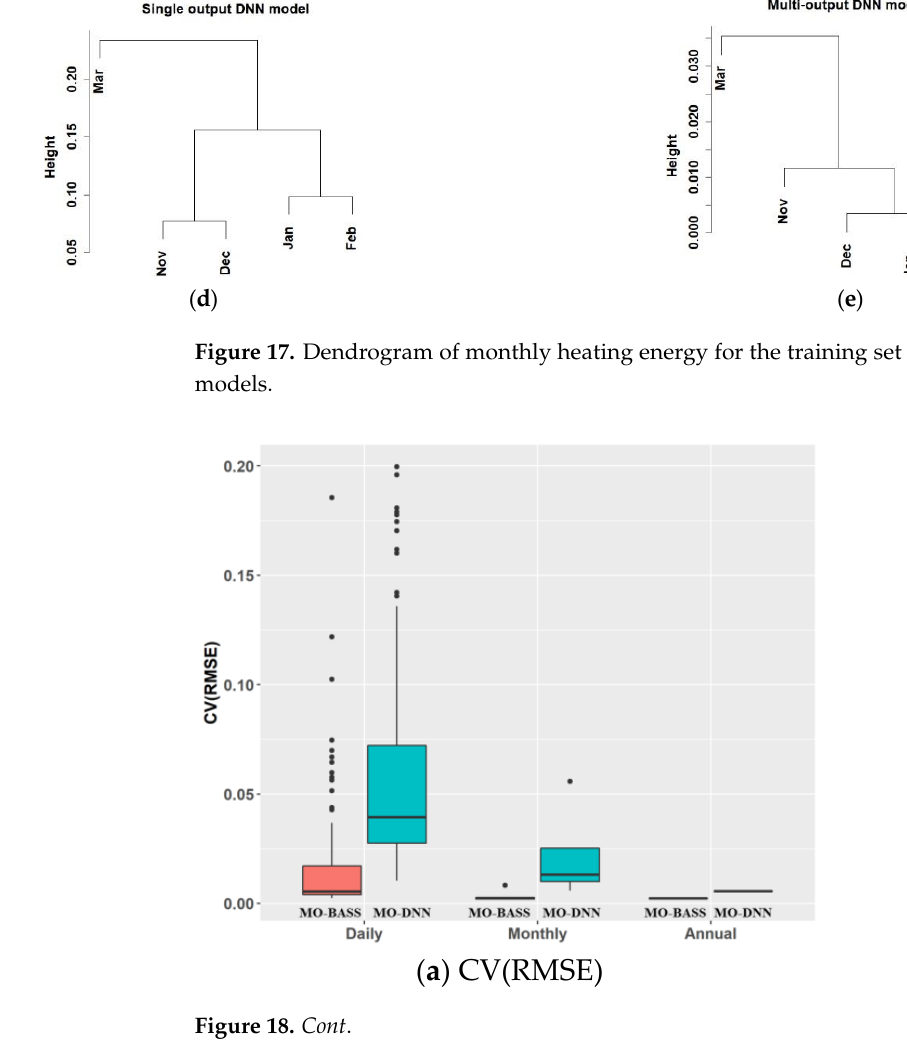
Figure 17. Dendrogram of monthly heating energy for the training set and four machine learning models.